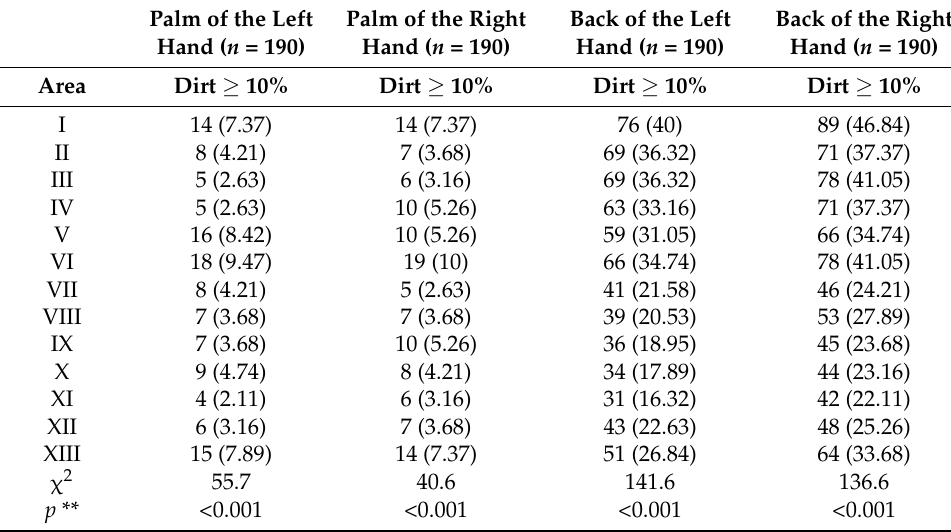
Figure 3. Improperly disinfected backs (dirt ≥10%). Table 2. Distribution of students with dirt at level at least